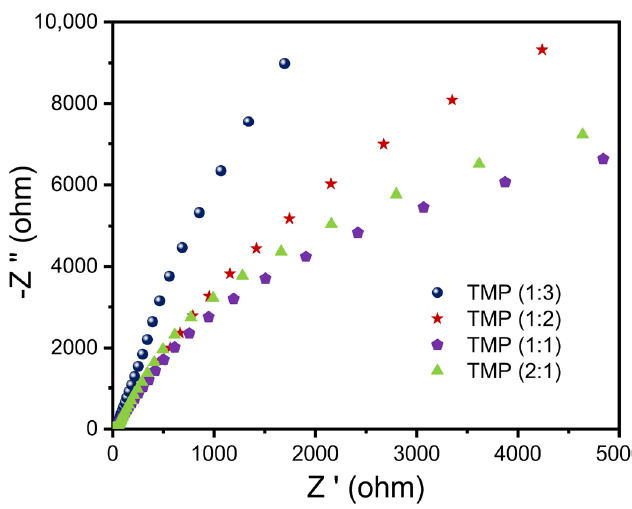
Figure 6. Electrochemical impedance spectroscopy (EIS) of TMP.